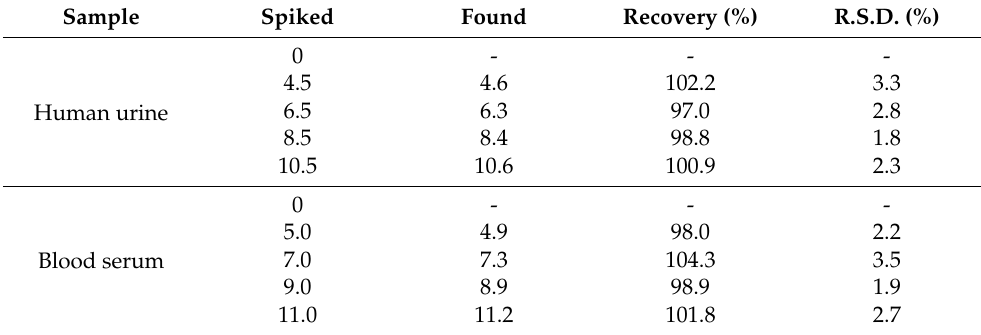
Table 2. Confirmed applicability of MnO 2 NR-IL/CPE in sensing the SAA in real specimens (n = 5); all concentrations are in µ M. Sample Spiked Found Recovery (%)